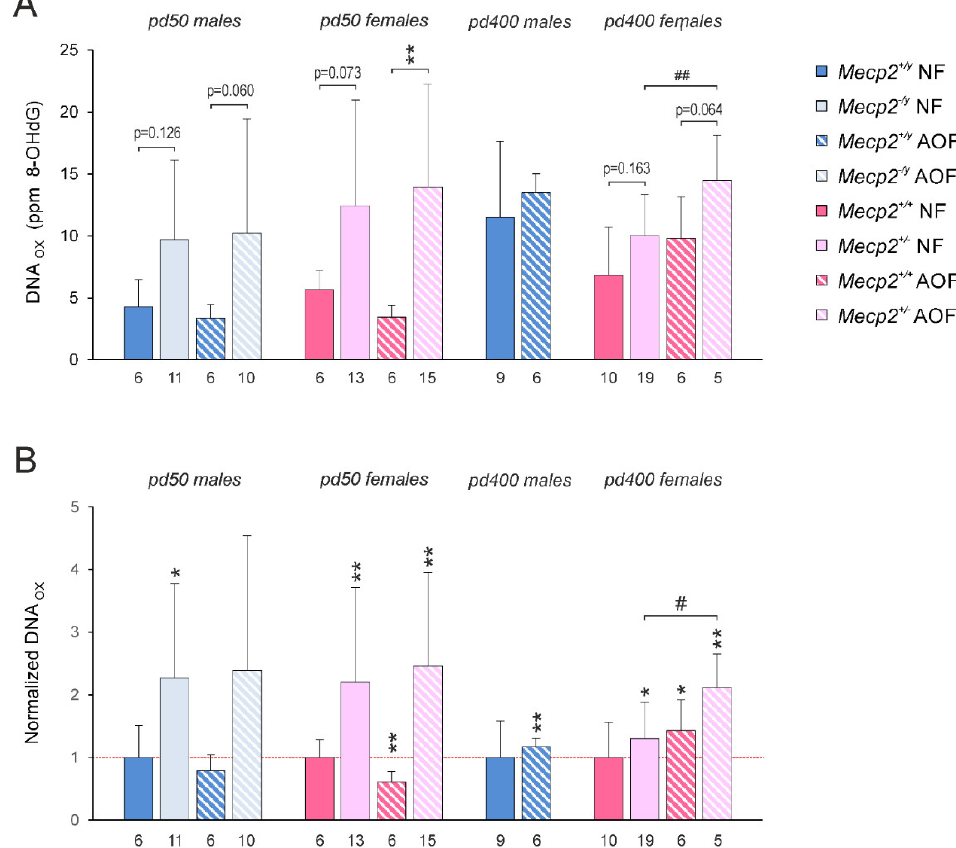
Figure 8. Intensified DNA oxidation in Mecp2 -mutant cortex. ( A ) Both Mecp2 −/ y and Mecp2 +/− cortices showed increased levels of DNA oxidation on pd 50. This trend also applied to Mecp2 +/− mice on pd 400. AOs only mediated some protection in WT mice but tended to mediate even higher levels of DNA oxidation in Mecp2 -mutant mice. The number of mice studied is reported below each bar. Plotted are the averaged degrees of DNA oxidation, i.e., the detected amounts of 8-OHdG in parts per million (ppm). ( B ) In addition, the normalized changes as referred to the respective WT control group were calculated. Genotype-related significant differences are indicated by asterisks (* p < 0.05; ** p < 0.01), and AO-evoked changes among Mecp2 +/− mice are marked by crosshatches (# p < 0.05). The statistical comparisons indicated in panel A were performed with two-way ANOVAs followed by all-pairwise Holm–Sidak testing. To rate the normalized DNA-oxidation levels (referred to respective WT controls defined as unity; see panel B), one-sample t-tests were used.